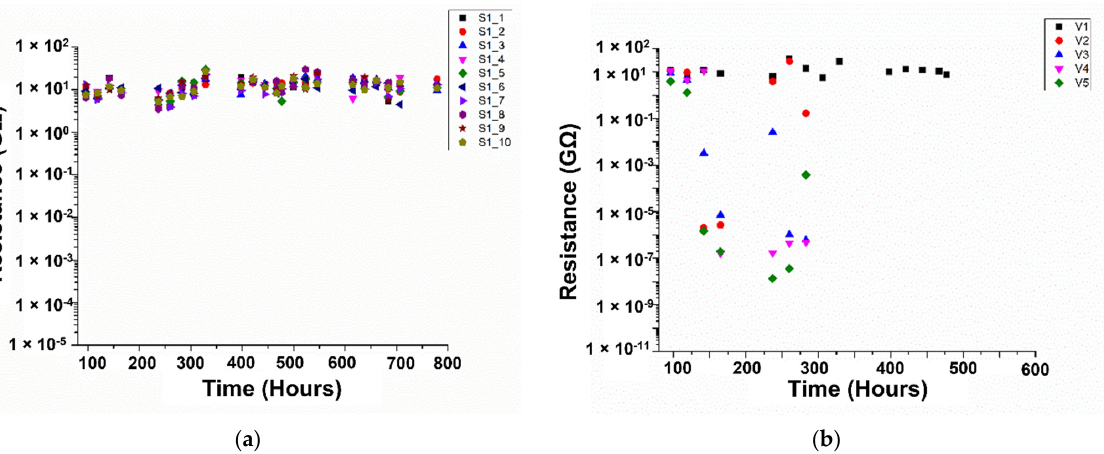
Figure 14. Resistance changes over time under the reliability test mentioned above: ( a ) 10 samples with the new de-penalization; ( b ) 5 samples with pizza cut de-penalization and the resistance fluctuation as reported earlier can be observed. The resistance in the Y -axis is in GW.